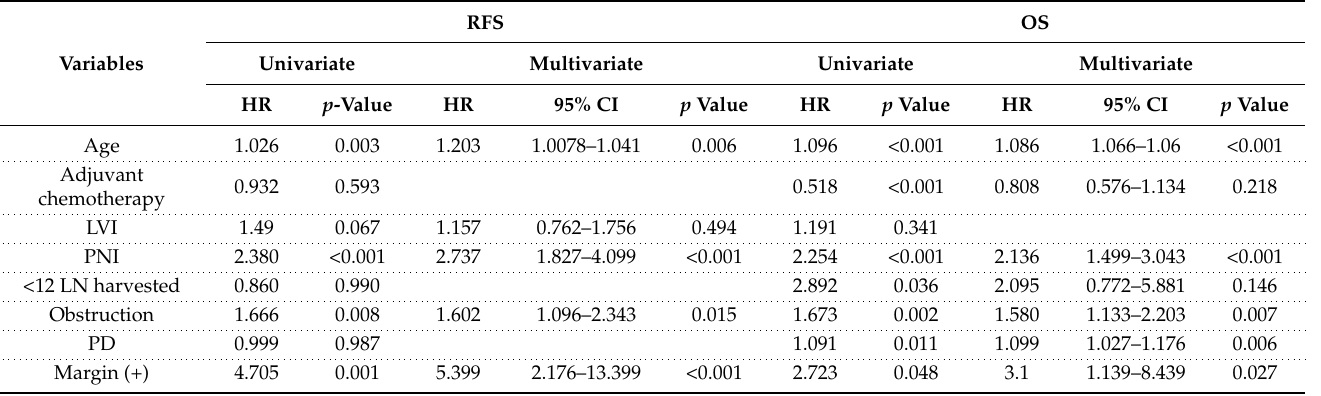
Figure 3. RFS and OS according to the administration of adjuvant chemotherapy in the overall cohort. ( A ) RFS did not differ according to the administration of adjuvant chemotherapy, ( B ) OS significantly improved for patients who received adjuvant chemotherapy Adj CTx; adjuvant chemotherapy; OS, overall survival; RFS, recurrence-free survival. Table 3. Factors associated with RFS and OS in the overall cohort of patients with T3N0 colorectal